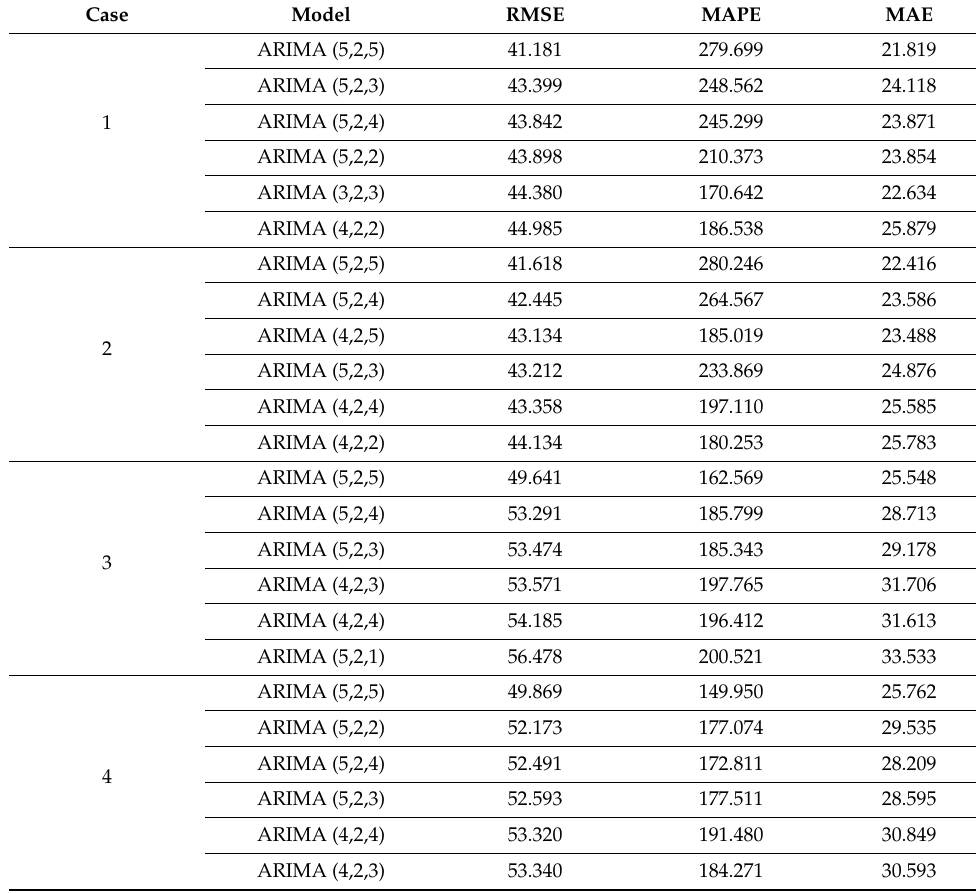
Table 3. Results of auto regressive integrated moving average (ARIMA) models for Group 1 (Case